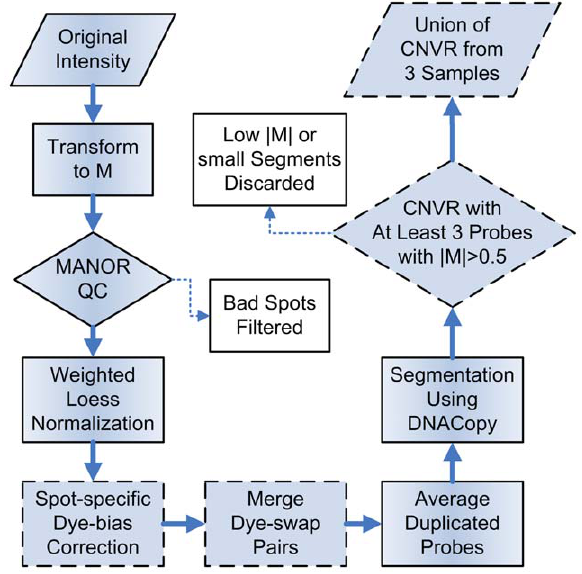
Figure 3. The pipeline of microarray data processing. The shapes bordered by dash-line represent the steps specifically implemented for this study.